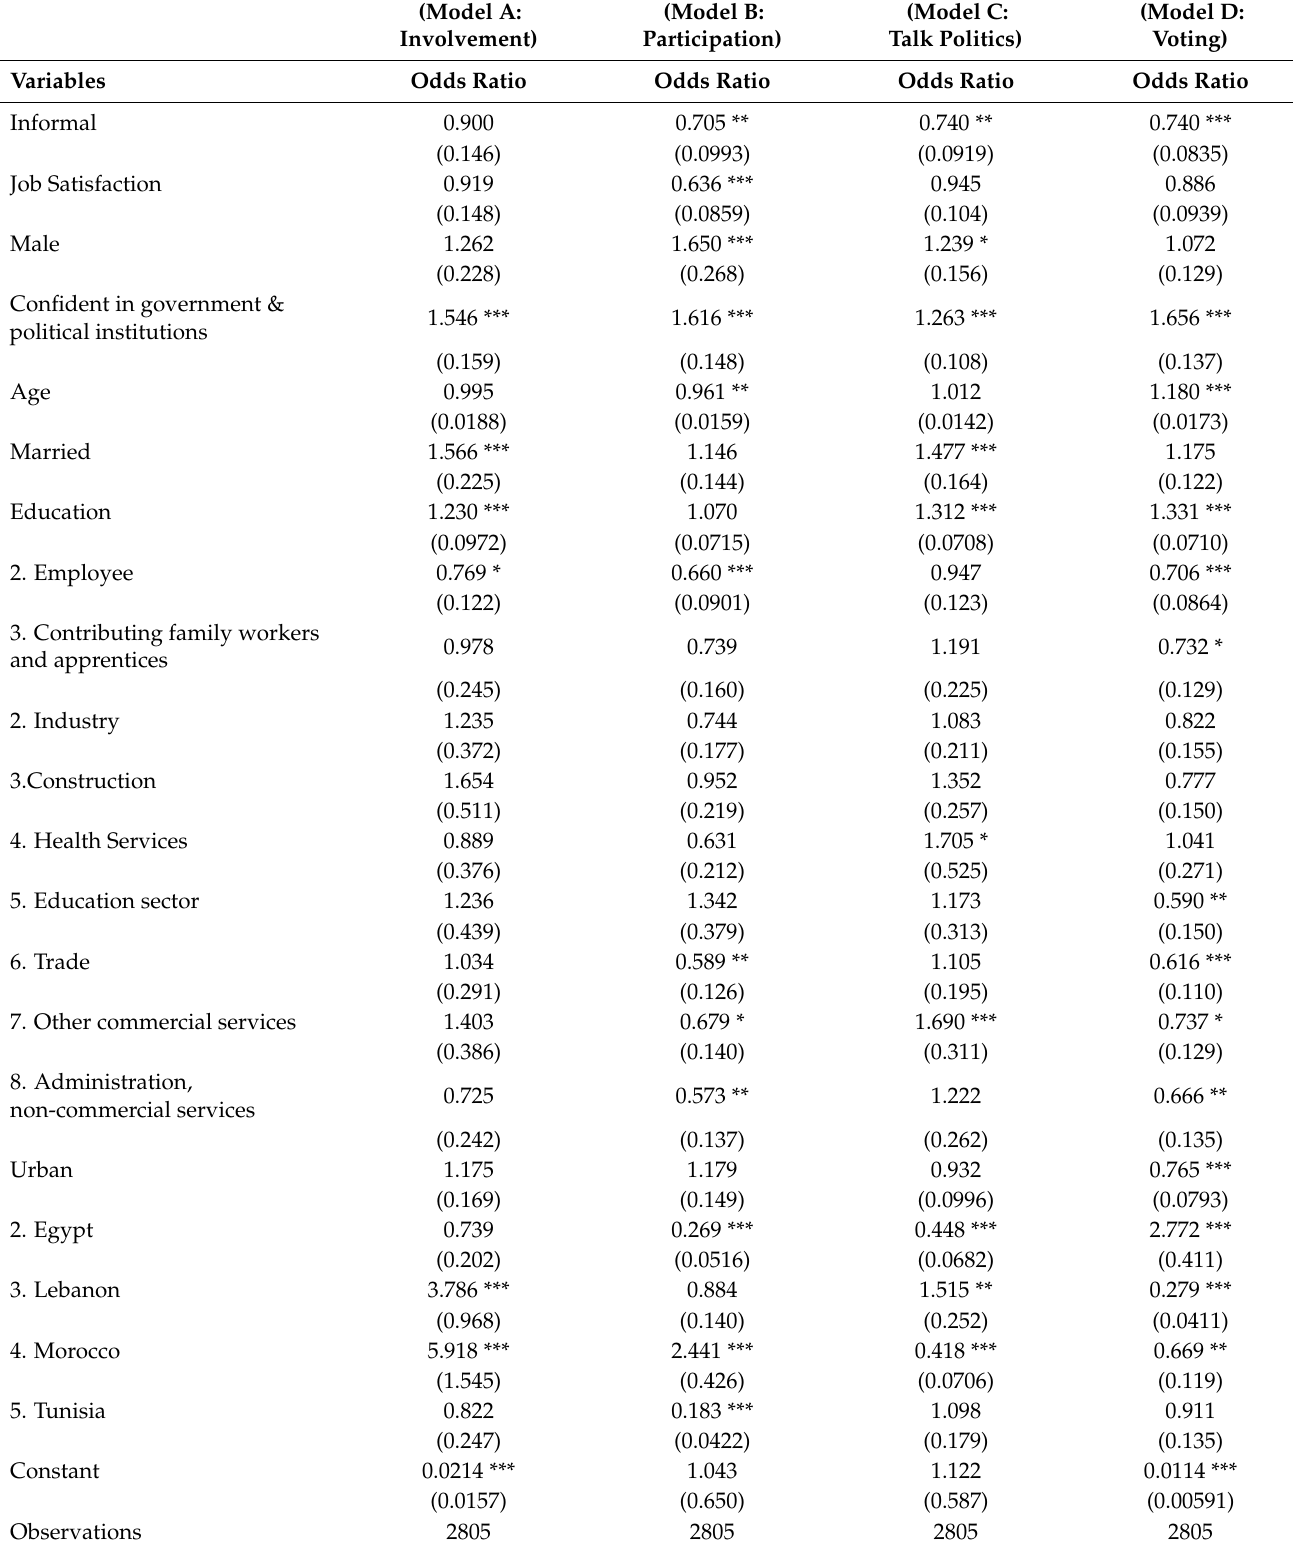
Table 1. Logit models predicting political